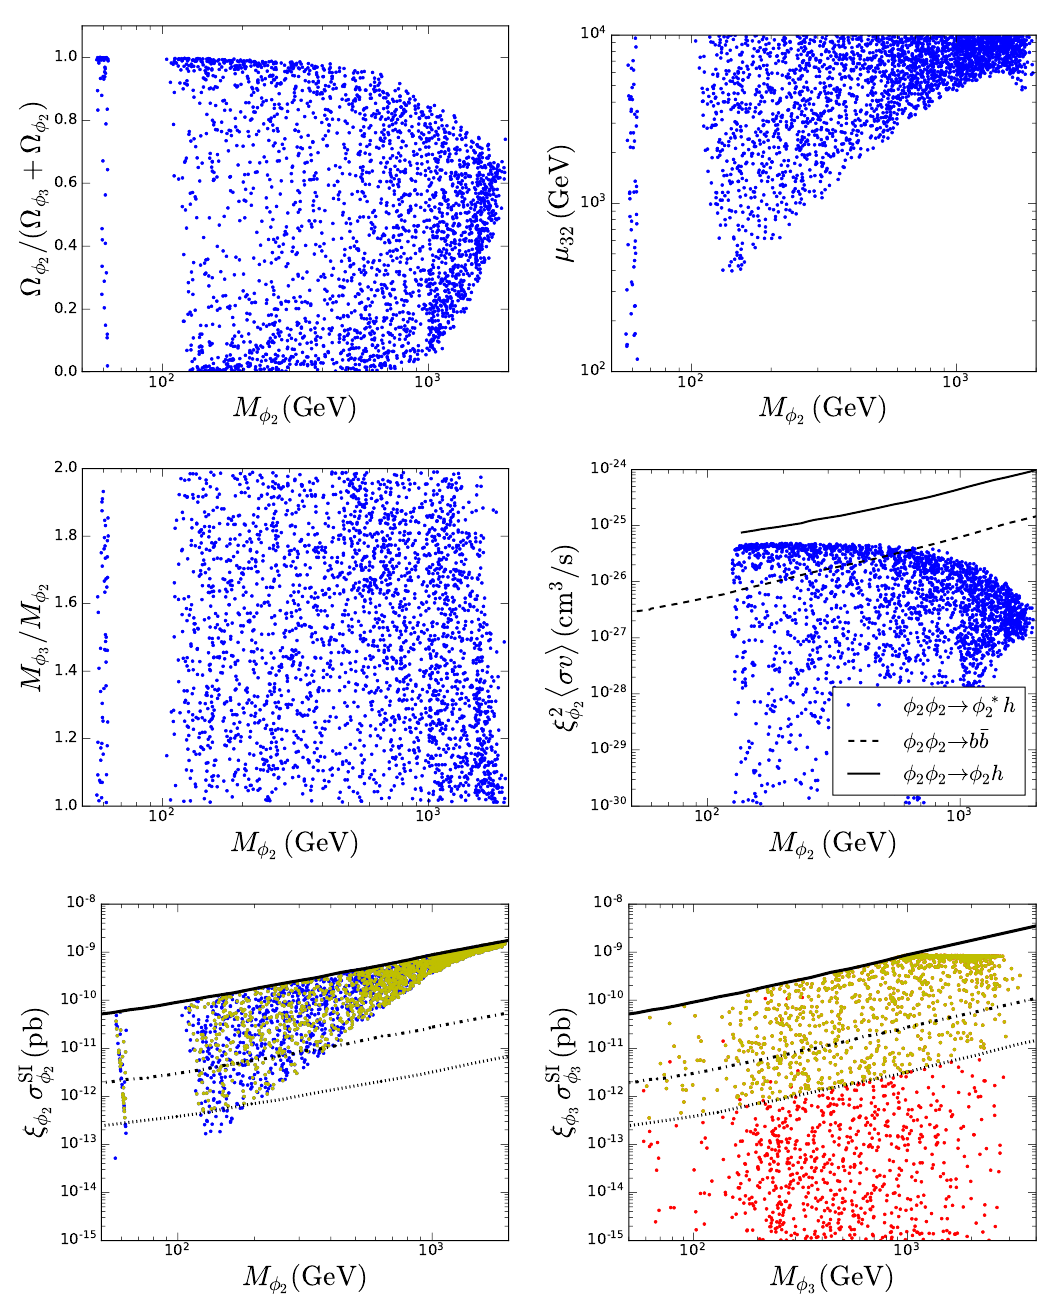
Figure 8 . A sample of viable points of the Z 6 (23) model with M φ dimensions. The top panels show scatter plots of M φ In the center panels, the ratio of dark matter masses (left) and the most relevant indirect detection signal (right) are illustrated. The direct detection prospects are shown in the bottom panels for φ 2 (left) and φ 3